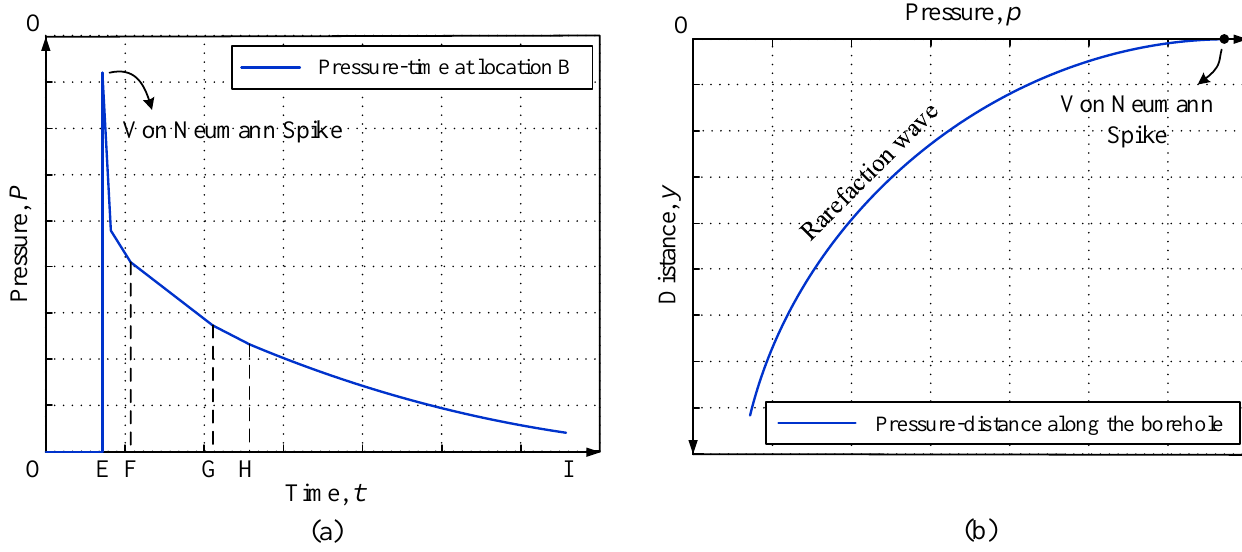
Figure 2. The rock mass response to explosion wave in the form of ( a ) p – t and ( b ) p – y